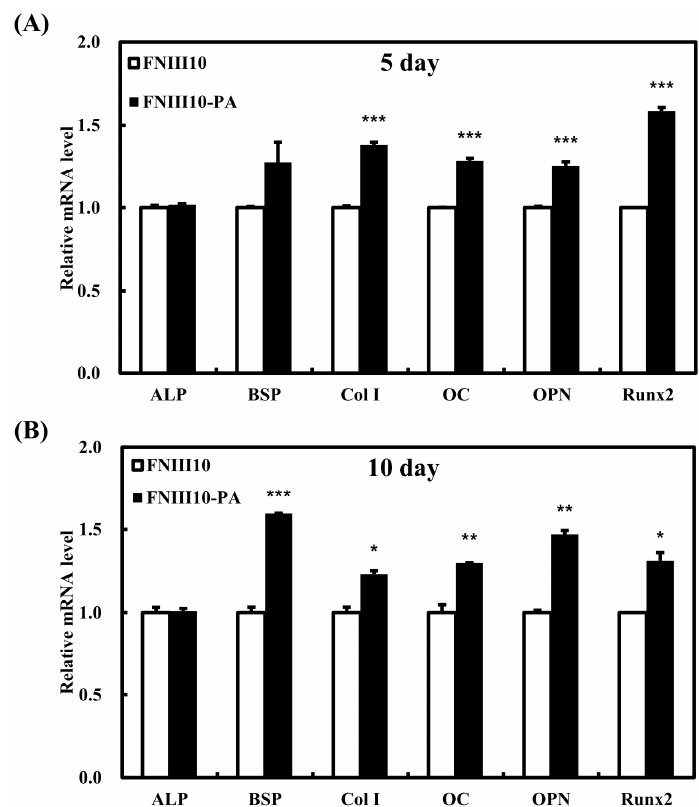
Figure 5. The osteogenic differentiation activity of FNIII10-PA on PCL fibers at 5 days ( A ) and 10 days ( B ). PCL fibers were placed in 24-well plates and coated with 5 μ g·mL − 1 of FNIII10 or FNIII10-PA overnight at 4 °C. MC3T3-E1 cells were cultured at a density of 5 × 10 4 cells and incubated for 5 and 10 days at 37 °C. Quantitative real-time PCR results were analyzed. * p < 0.05, ** p < 0.005, and *** p < 0.001. Genes: alkaline phosphatase ( ALP) , bone sialoprotein ( BSP ), collagen type I ( Col I ), osteocalcin ( OC ), osteopontin ( OPN ), and runt-related transcription factor 2 ( Runx2 ).